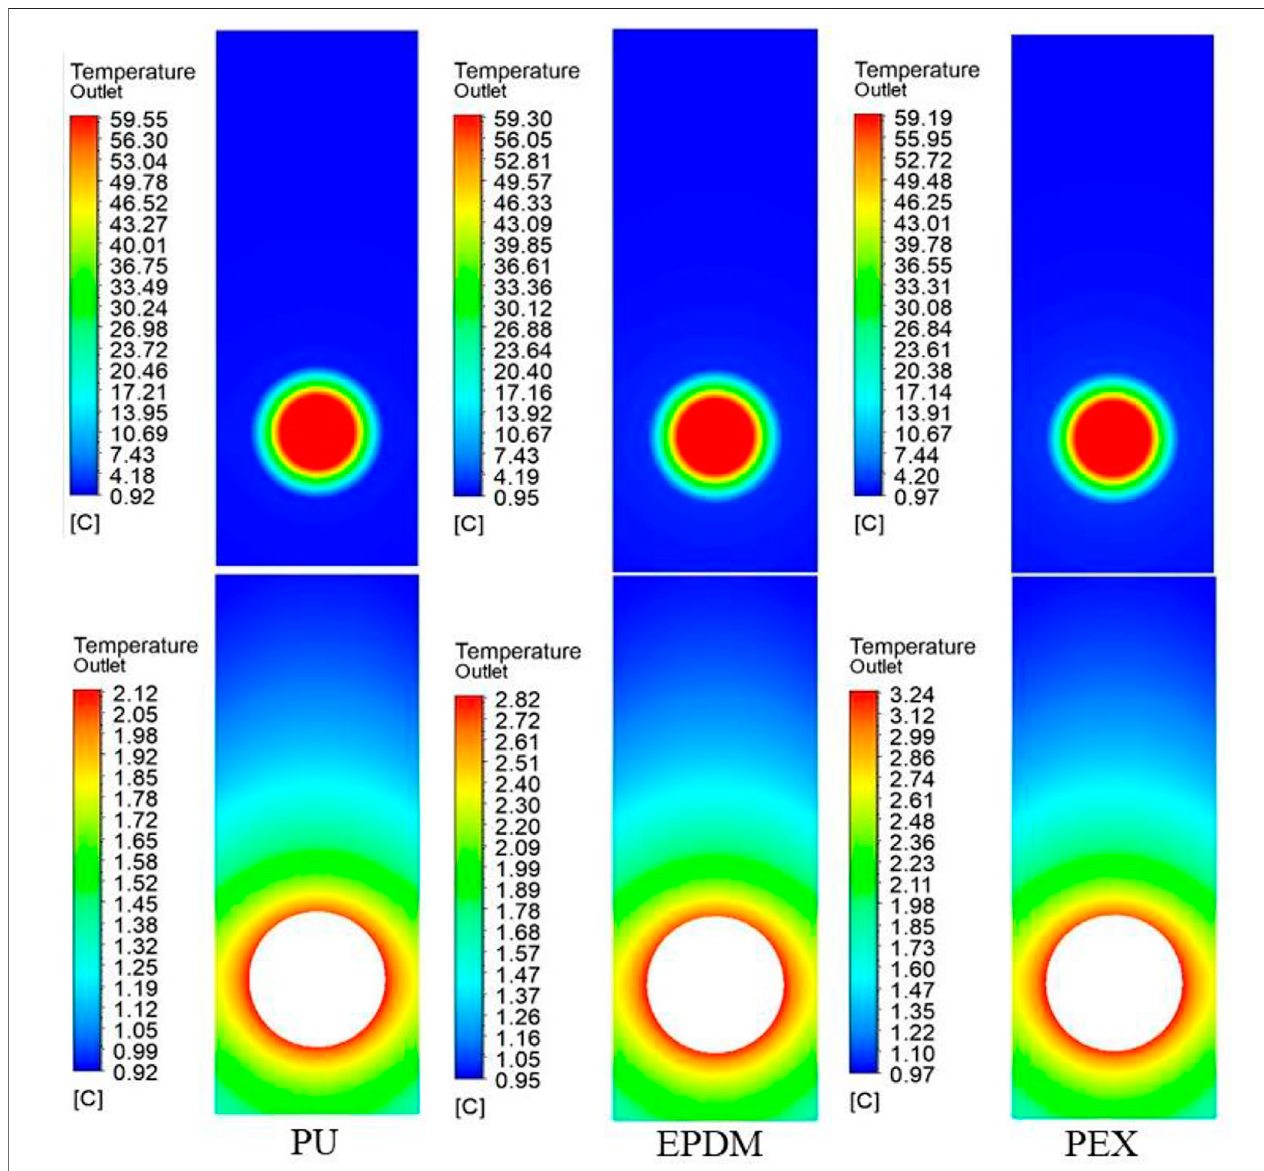
FIGURE 5 | Contours of radial temperature distribution at the pipe outlet through the insulations including the soil domain during winter with (A) PU Foam (B) EPDM Rubber Foam (C) PEX Foam.